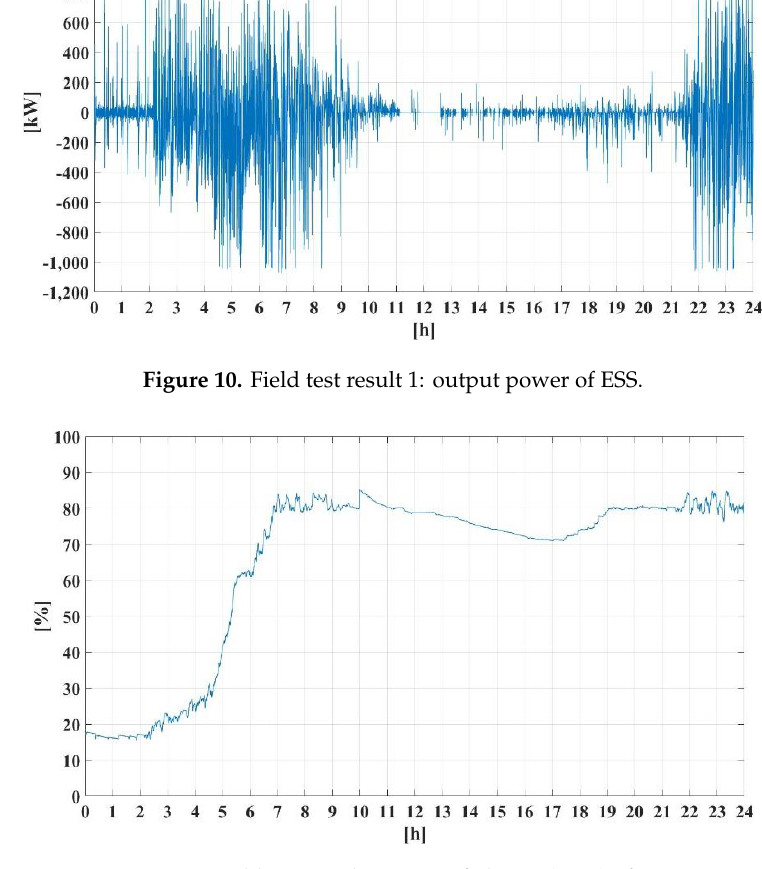
Figure 11. Field test result 1: state-of-charge (SOC) of ESS.